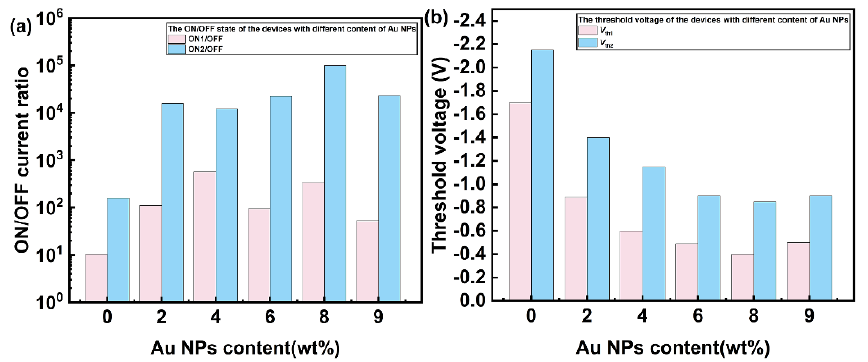
Figure 7. ( a ) Influence of Au NPs’ content on the switching current ratio and ( b ) threshold voltage of the ITO/PF-BBO/Au/Al device.